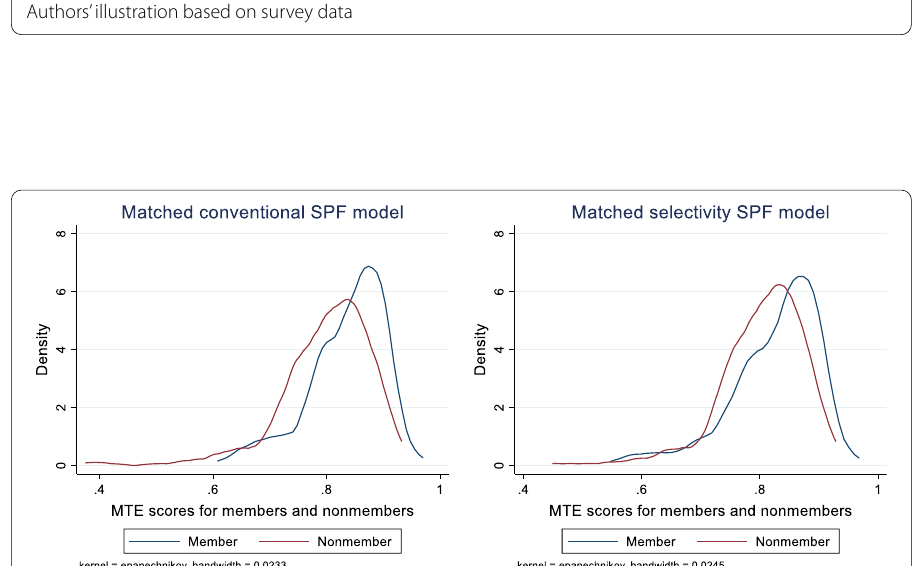
Fig. 5 Metafrontier efficiency scores for members and nonmembers in matched SPF models. Source : Authors’ illustration based